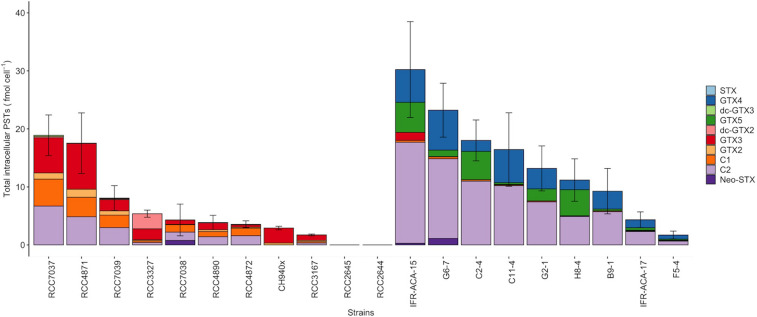
Intracellular STX-group content in the Alexandrium minutum
(left) and A. pacificum
(right) strains (including Neo-STX, dc-GTX2/3, GTX2/3, C1, C2, GTX1/4) (means ± SD, n = 3. Error bars represent standard deviations).